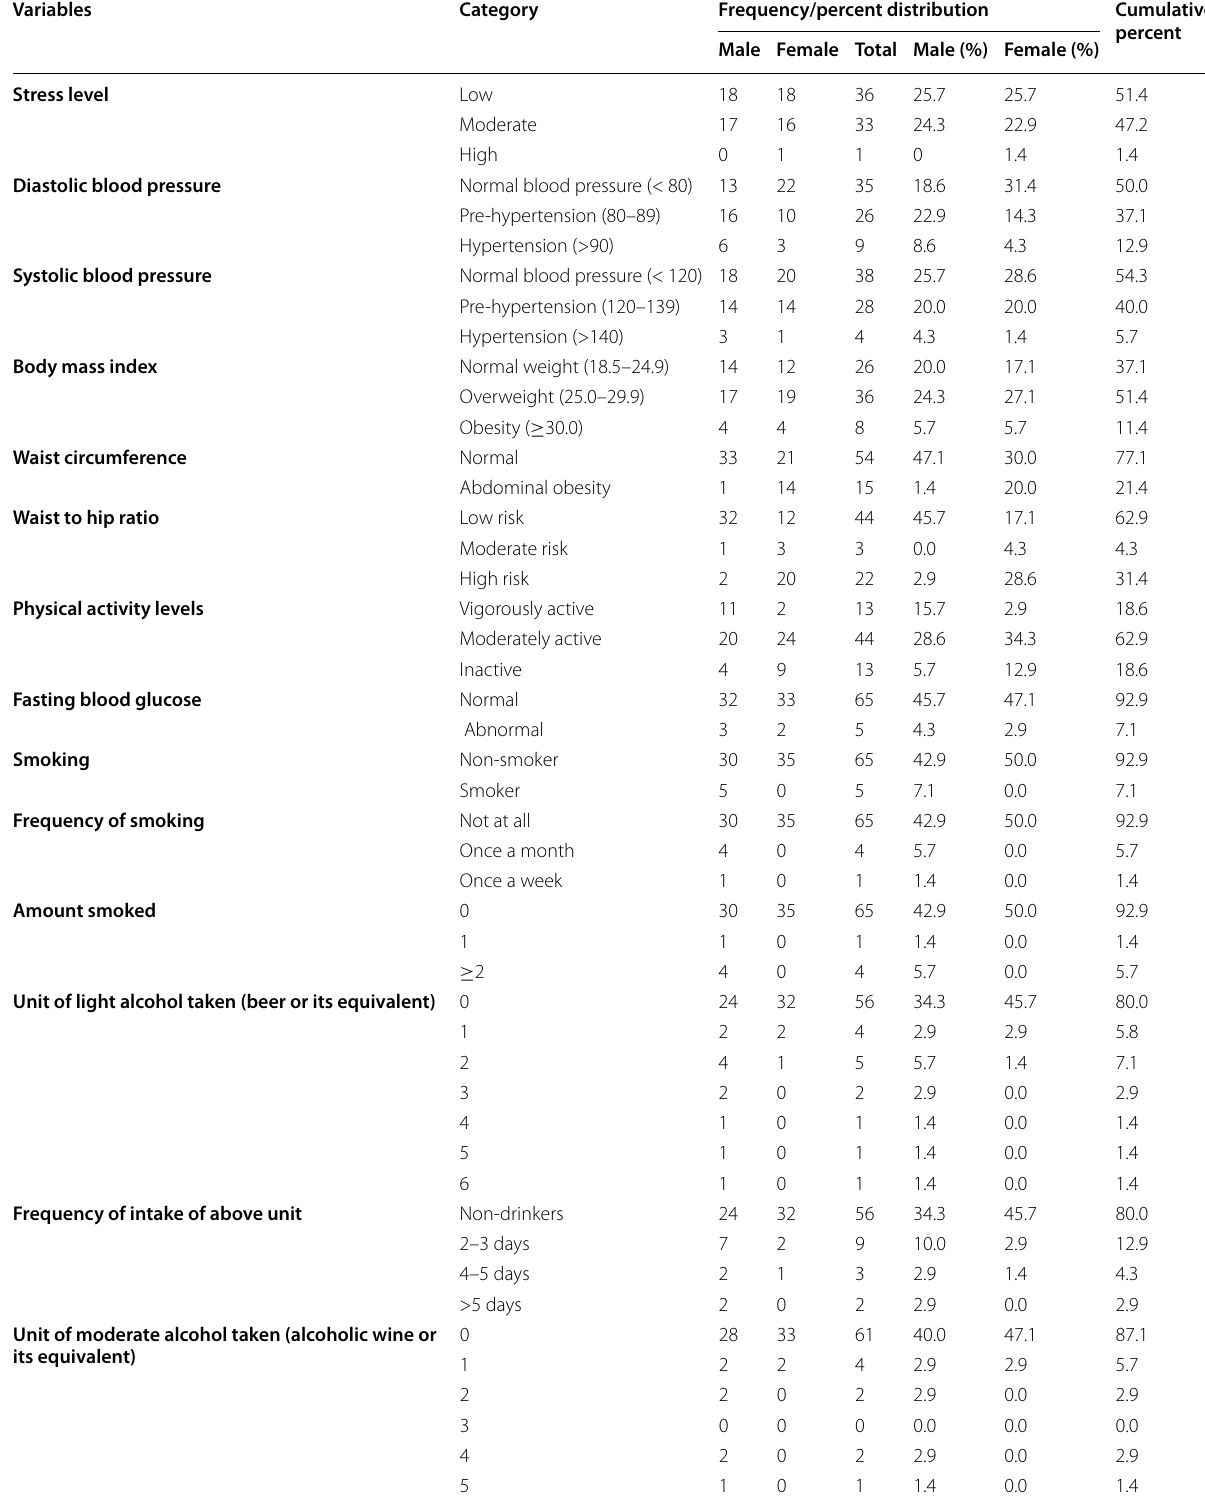
Table 2 Sex distribution of cardiovascular disease risk factors